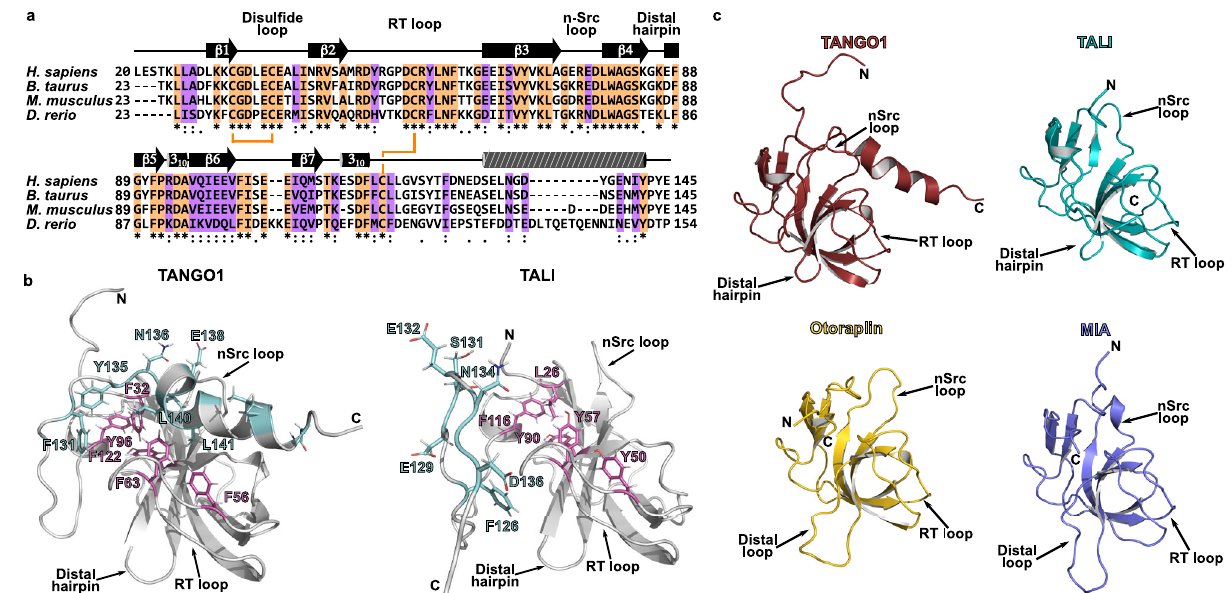
Fig. 4 | A conserved C-terminal helix is unique for vertebrate TANGO1. a Multiple sequence alignment of the cargo-recognition domain of TALI from dif- ferent vertebrate organisms. Conserved and semi-conserved residues are high- lighted in orange and purple, respectively. Conserved disul fi de bridges are indicatedbyorangelines.C-terminalhelixfoundinTANGO1isindicatedbystriped cylinder. b Structures of human TANGO1 ’ s and TALI ’ s cargo-recognition domain predictedbyAlphaFold.Conservedaromaticresidueswithinthedomainareshown